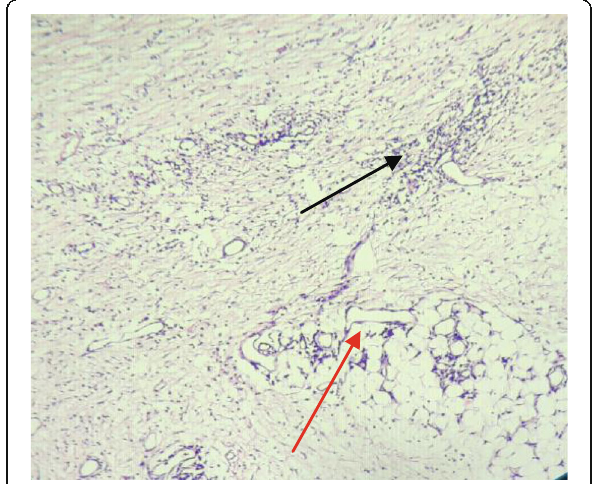
Fig. 8 H and E stained LP (magnification 100x) and HP (magnification 400x) photomicrographs showing dilated lymphatic channels (red arrow) alongwith lymphoid aggregates (black arrow) which are consistent with a diagnosis of